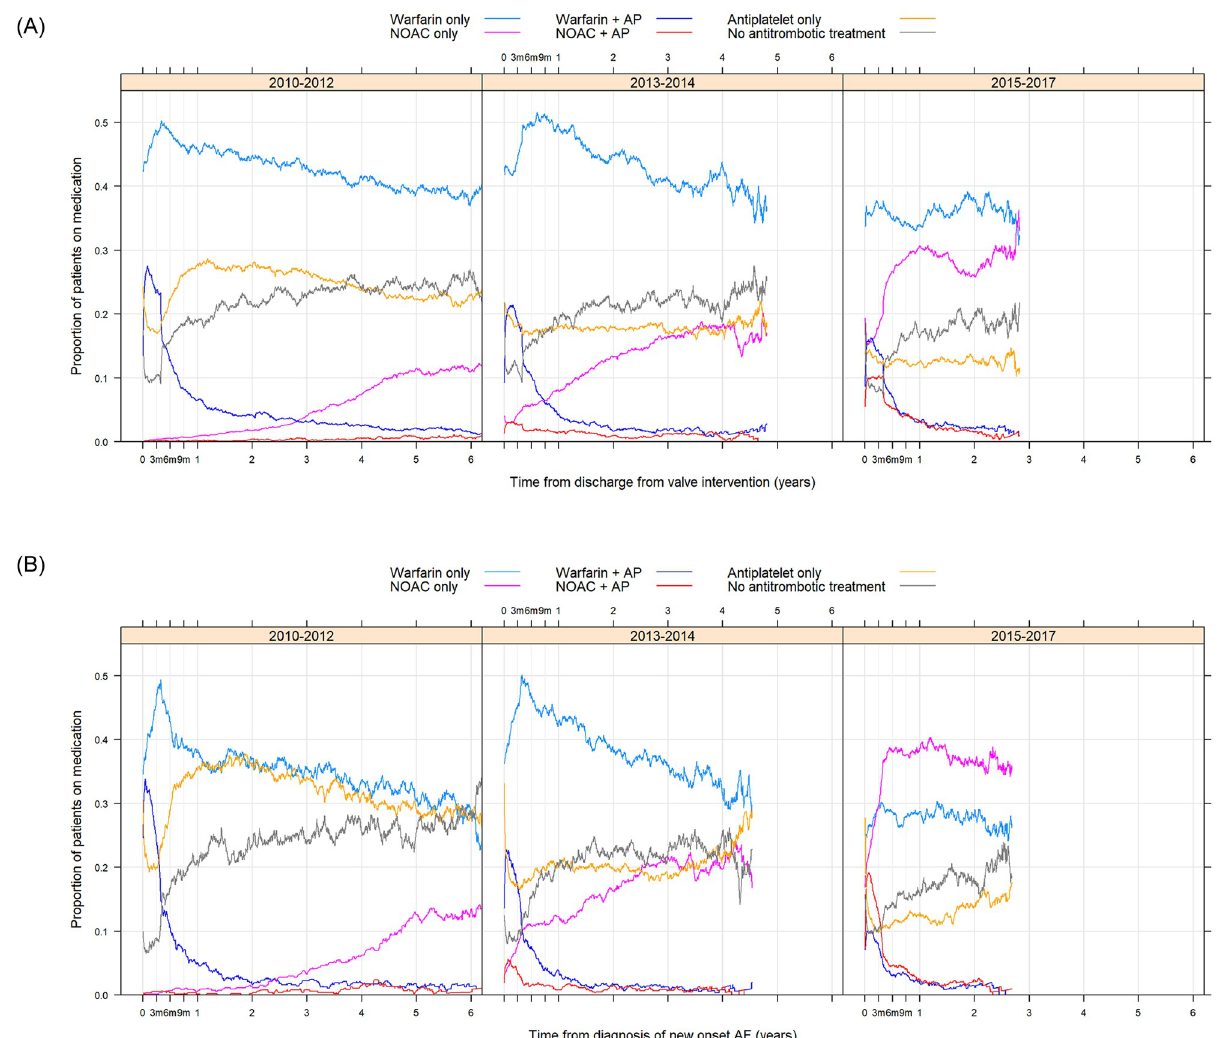
Fig 5. The proportion of antithrombotic exposure in the history of atrial fibrillation (A) patients exposed to warfarin, warfarin + anti-platelet (AP), NOAC, NOAC + AP, anti-platelet, no treatment during the follow-up period after discharge from valve intervention. The figure describe